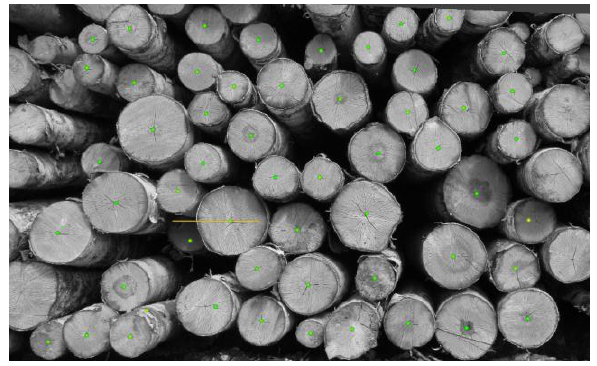
Figure 8. Result of corresponding ends detection